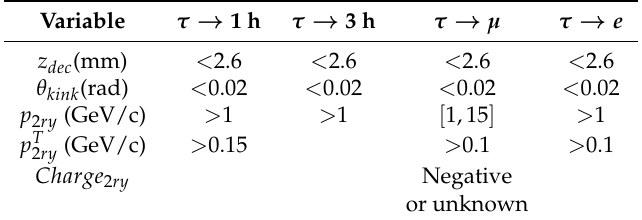
Table 1. Selection cuts for the different τ decay topologies. z dec is defined as the distance between the decay vertex and the downstream face of the lead plate containing the primary vertex. θ kink is the angle between the τ candidate and its daughters. p 2 ry is the total momentum of the visible tracks coming out from the decay vertex. For one prong decays, p T is the daughter transverse momentum with respect 2 ry to the τ candidate direction. For muonic decays, also the charge of the daughter muon, Charge 2 ry , is considered. Variable τ → 1 h τ → 3